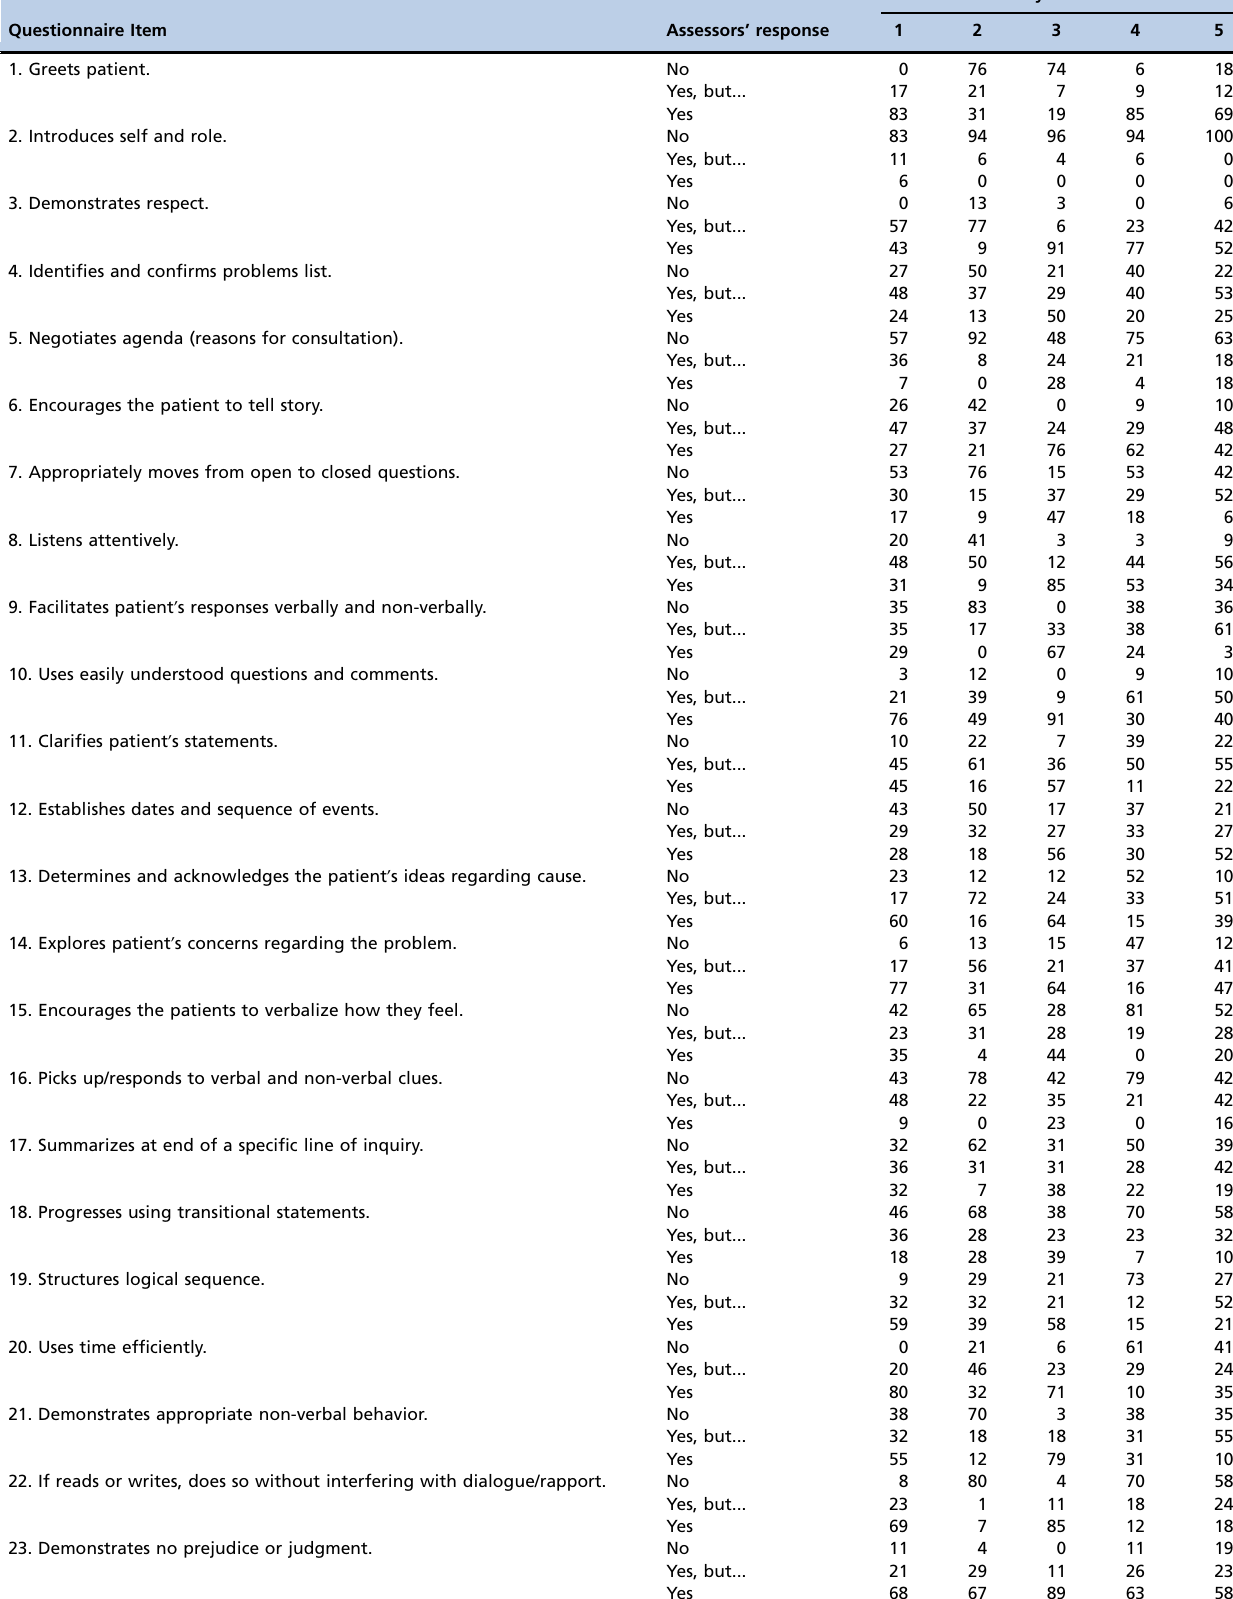
Table 1 - Descriptive statistics of responses to the 28-item CCOG questionnaire with percentages according to response